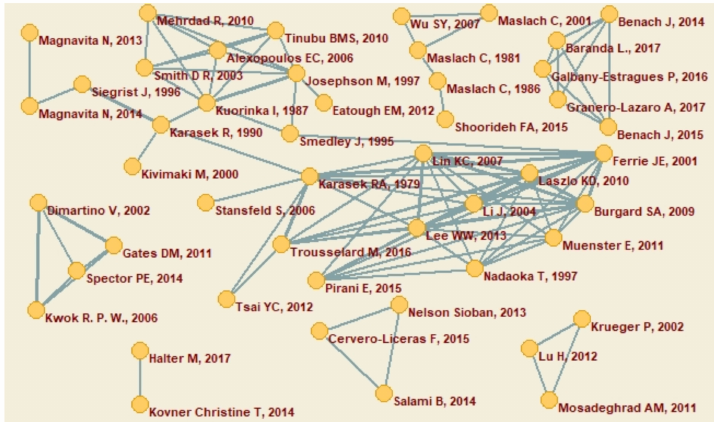
Figure 3. Co-citations network ( ≥ 2 co-citations of